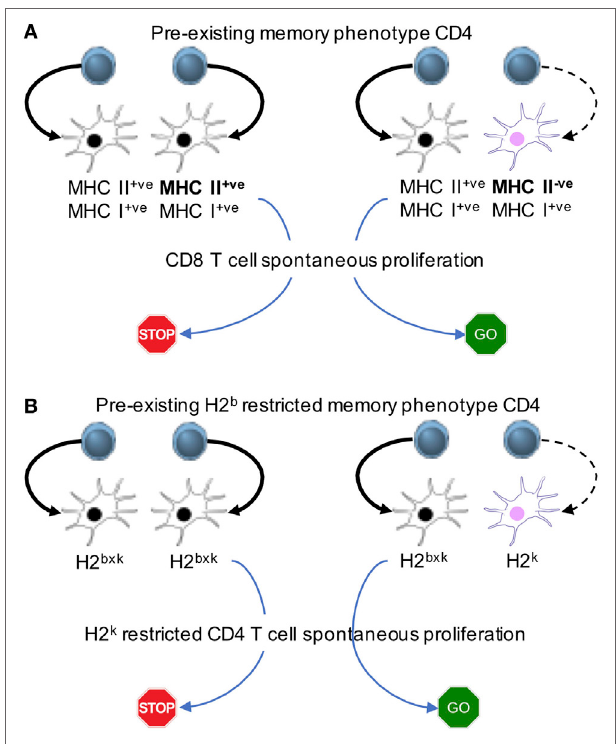
FiGURe 3 | Memory cell-induced regulation of spontaneous proliferation operates via antigen presenting cells (APCs). Mixed bone marrow chimeras in which different APC populations expressing MHC I and II or MHC I alone (A) or expressing different MHC II haplotypes (B) are created. The first cohort of CD4 T cells is transferred to generate “pre-existing” memory phenotype cells. The second cohort of naive CD8 (A) or naive CD4 (B) cells is transferred into the recipients. The model system uncovers that the interaction between APCs and pre-existing memory phenotype CD4 T cells is essential to limit the proliferation of new naive T